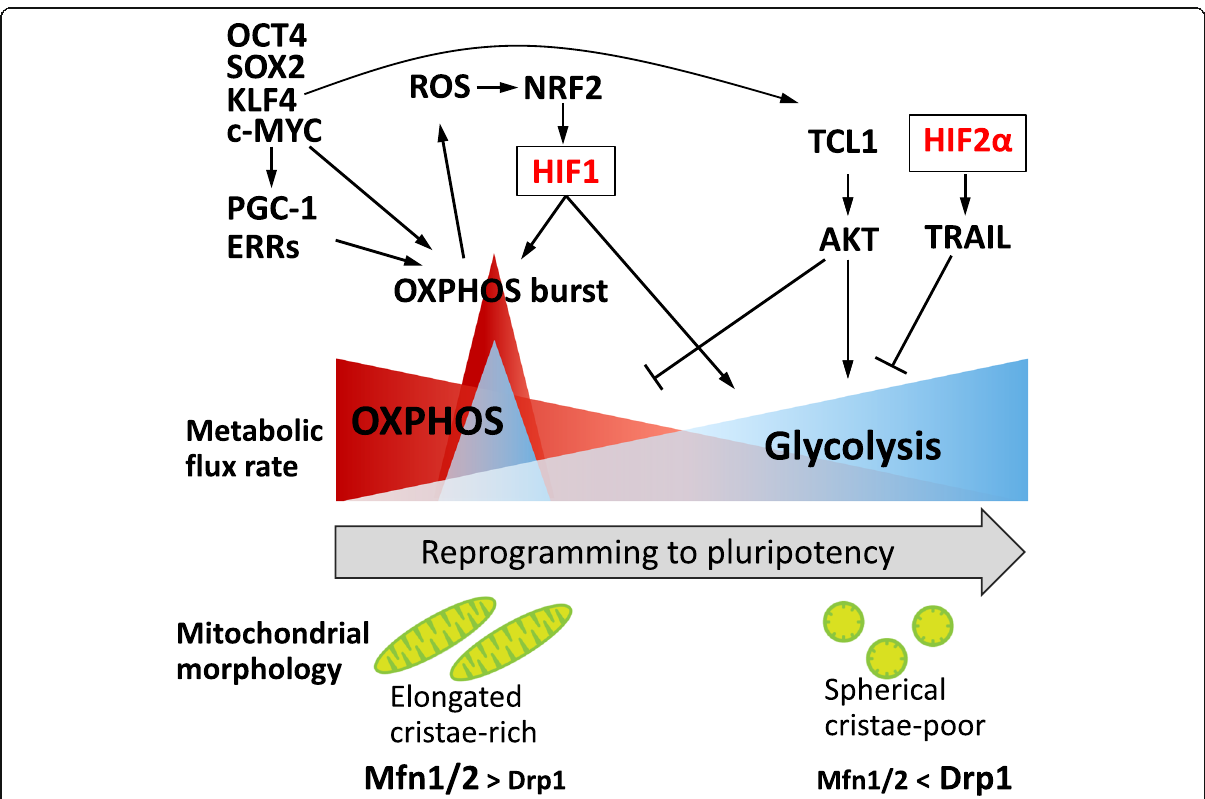
Fig 2 Metabolic shift and its related molecules during reprogramming to pluripotency. DRP1, dynamin-related protein 1; ERRs, estrogen-related nuclear receptors; HIF, hypoxia-inducible factor; Mfn, mitofusin; NRF2, nuclear factor erythroid 2-related factor 2; OXPHOS, oxidative phosphorylation; PGC-1, peroxisome proliferator-activated receptor gamma coactivator-1; ROS, reactive oxygen species; TRAIL, TNF-related apoptosis-inducing